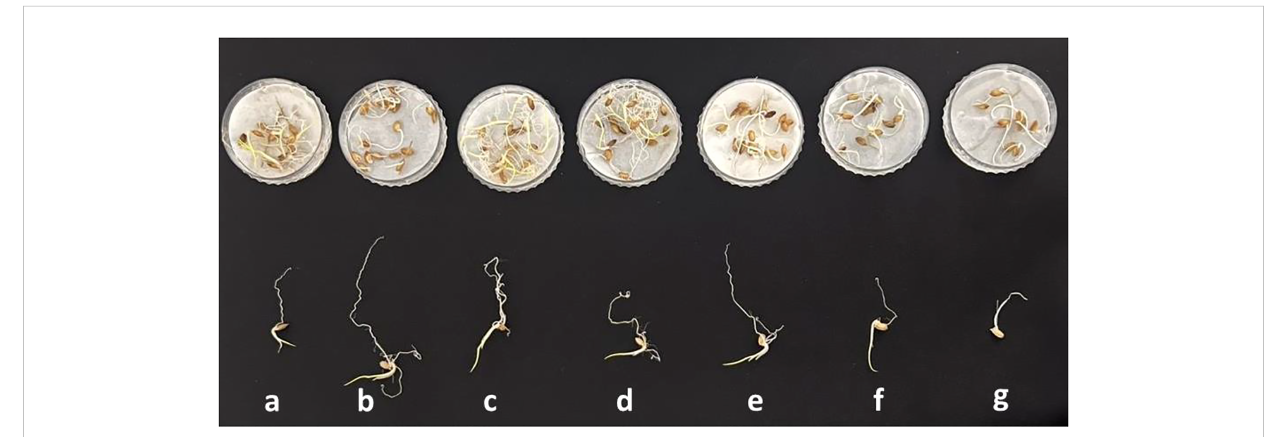
FIGURE 8 In vitro seed biopriming with different concentrations of the polyethylene glycol: (A) normal control; (B) microbial pellet; (C) microbial pellet + 5% PEG (D) microbial pellet + 10% PEG; (E) microbial pellet + 15% PEG; (F) microbial pellet + 20% PEG; and (G) microbial solution. PEG, polyethylene glycol.